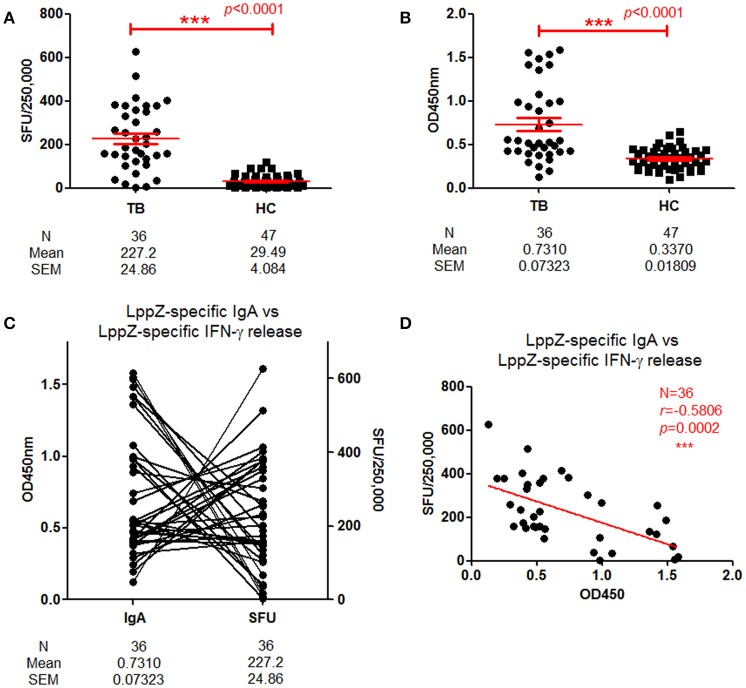
Correlation between LppZ-specific IgA and LppZ-specific IFN-γ releasing level in TB patients. (A) LppZ-specific IFN-γ releasing cell numbers in PBMCs from TB patients (N = 36) and HCs (N = 47). The P-value was calculated by using Mann Whitney test. (B) OD450-values of LppZ-specific IgA in TB patients (N = 36) and HCs (N = 47). The P-value was calculated by using Mann Whitney test. (C) Complementarity analysis between LppZ-specific IgA and LppZ-specific IFN-γ releasing level in TB patients (N = 36). Each line represented one individual. (D) Correlation analysis between LppZ-specific IgA and LppZ-specific IFN-γ releasing level in TB patients (N = 36). The correlation coefficient r (r = −0.5806) and the P-value (p = 0.0002) were calculated using the Spearman rank test. SFU: Spot forming unit. ***p < 0.001.